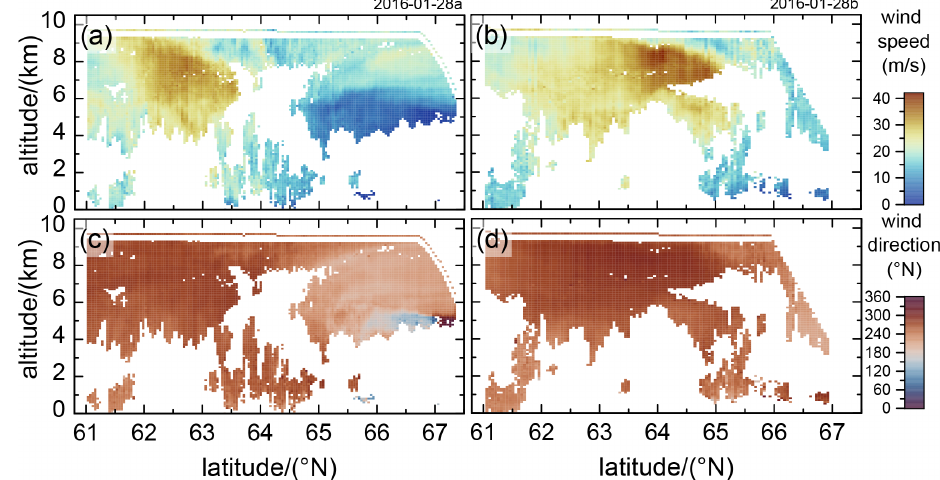
Figure 4. Horizontal wind speed (top, panel a and b ) and wind direction (bottom, panel c and d ) derived from 2µmDWL observations acquired in wind mode on the flight legs FL1 (a, c) and FL4 (b, d) flown on 28 January 2016 (see also Table 1 and Fig. 1). The corresponding wind speed and direction measured in situ by the Falcon nose boom is indicated by the thin line at flight level.